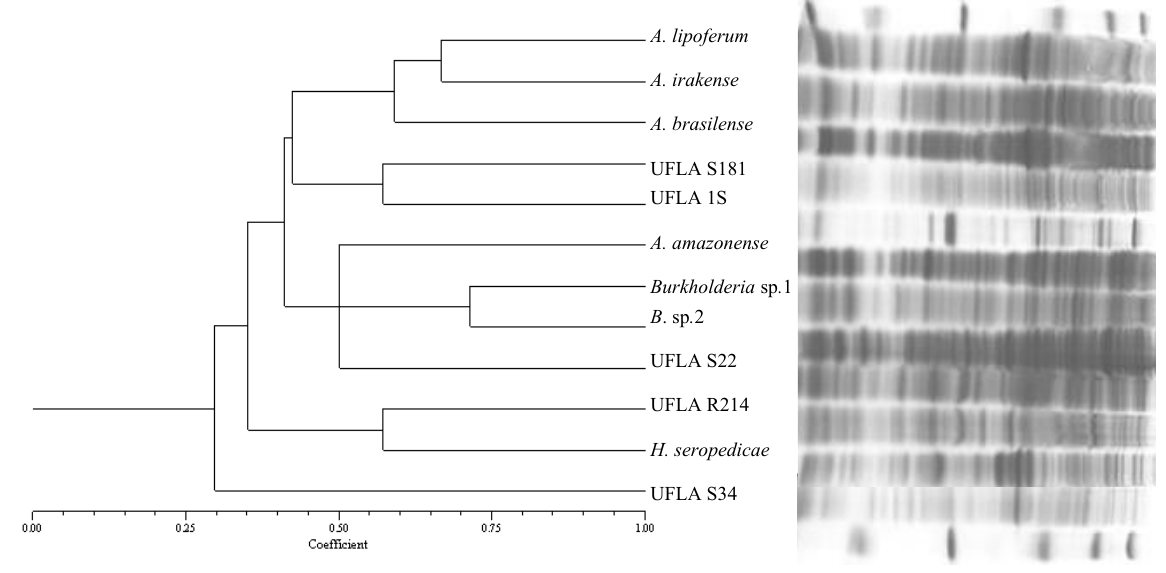
Fig. 5 – Dendrogram and total protein profiles of associative diazotrofics bacteria: MWM (molecular weight marker), A. lipoferum (BR11080 T ), A. irakense (KCB1 T ), A. brasilense (BR11001 T ), UFLA S181, UFLA 1S, A. amazonense (BR11040 T ), Burkholderia sp.1 (BR 9004), B. sp.2 (BR11340), UFLA S22, UFLA R214, H. seropedicae , (BR11175 T ), UFLA S34 e